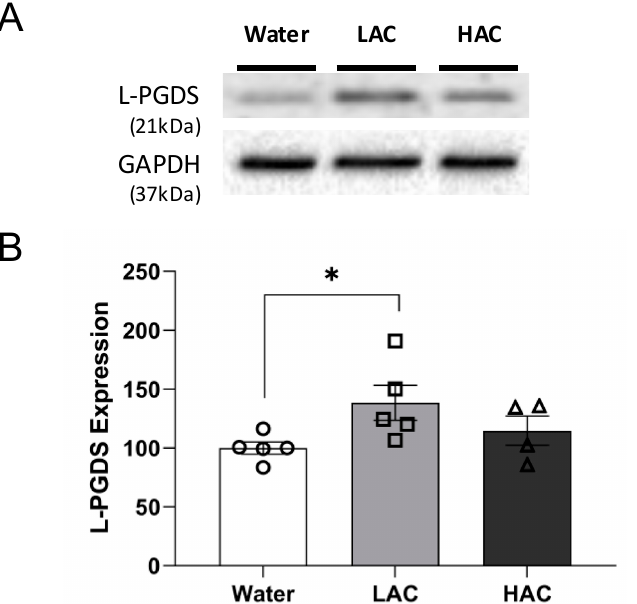
Figure 1. Effect of chronic ethanol consumption on protein expression of L-PGDS in the cerebral cortex. ( A ) Representative Western blots. ( B ) Values are means ± SEM for 4–5 mice in each group. * p < 0.05. Analyzed using one-way ANOVA with Dunnett’s post hoc test.